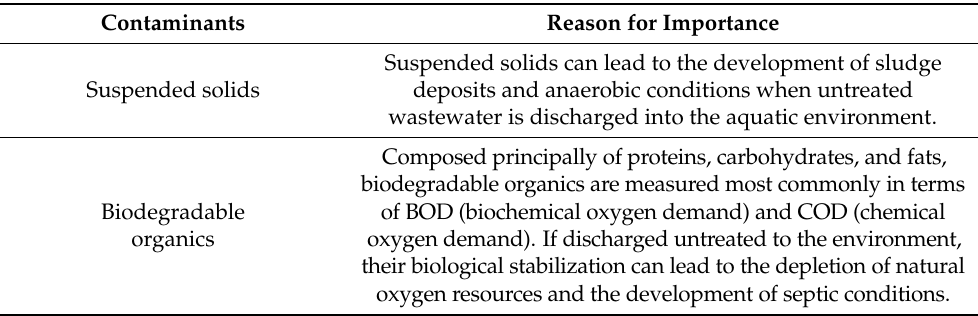
Table 2. Important contaminants of concern in wastewater treatment